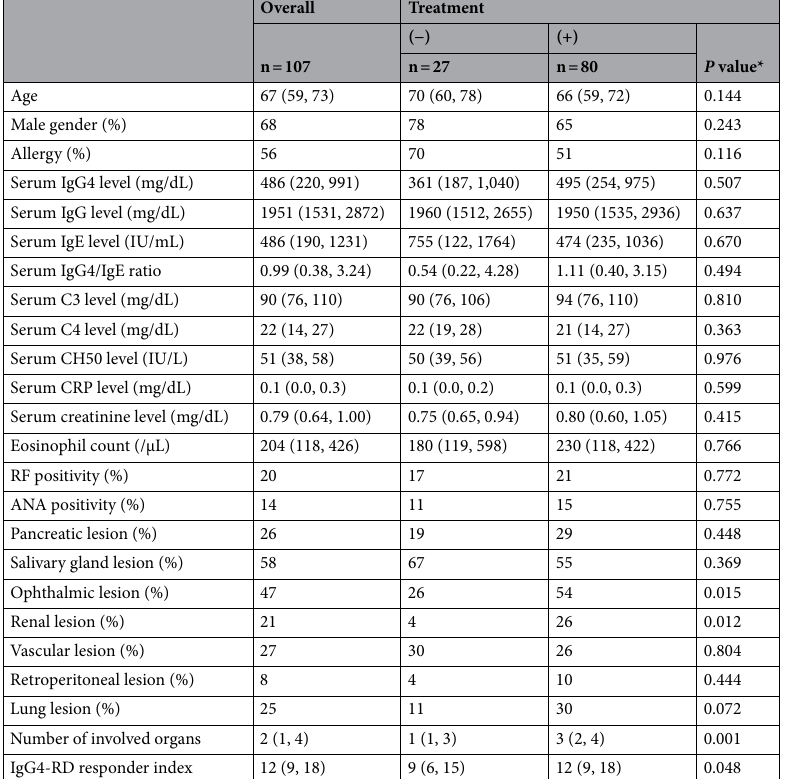
Table 1. Baseline clinical characteristics of 107 patients with IgG4-related disease. Conversion factor for Cr: mg/dL to μmol/L, × 88.4. Data are presented as median [interquartile range (IQR1, IQR3)]. *Treatment (+) versus Treatment (−). ANA anti-nuclear antibody, CRP C-reactive protein, IgG immunoglobulin G, IgG4 immunoglobulin G4, IgG4-RD immunoglobulin G4-related disease, IgE immunoglobulin E, PSL prednisolone, RF rheumatoid